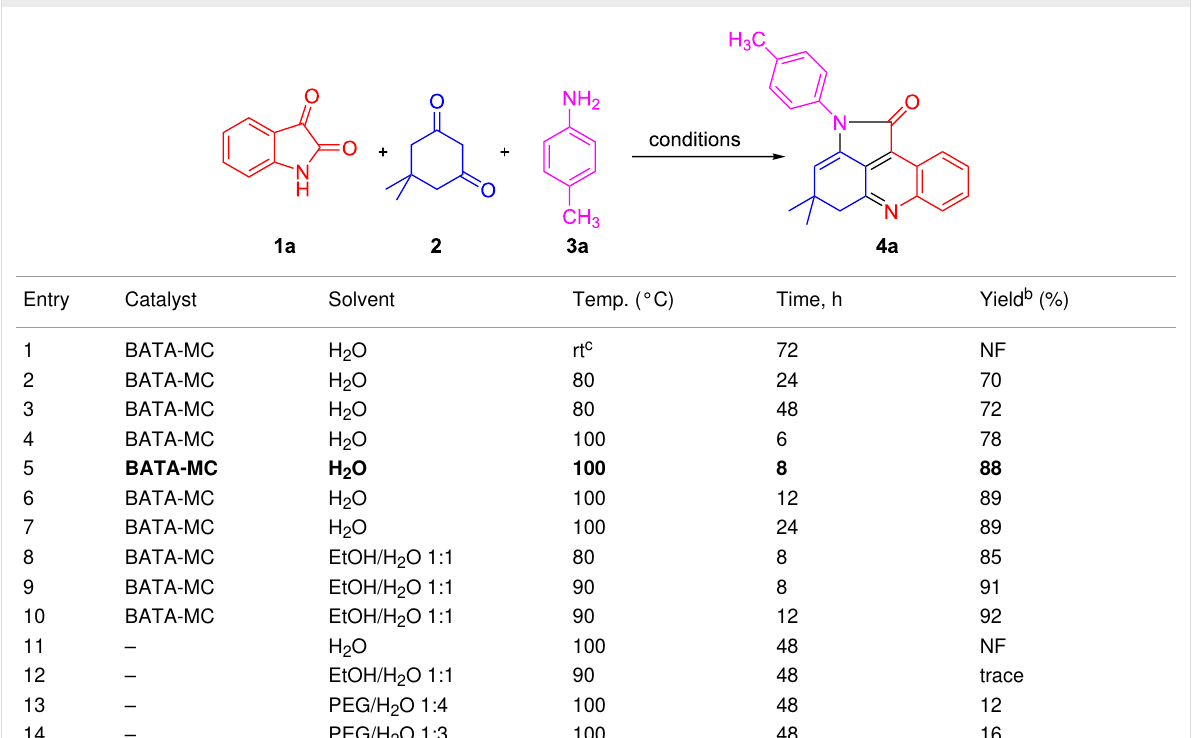
Table 1: Effect of various reaction parameters. a